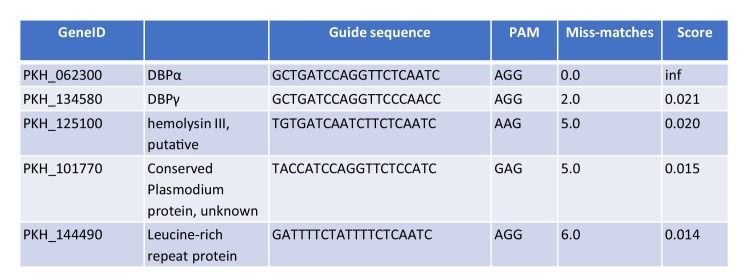
Off-target guide sequences for PkDBPα sgRNA.Table showing the five genes with highest off-target scores for the guide sequence targeting PkDBPα sgRNA. All five genes were PCR amplified and sequenced.